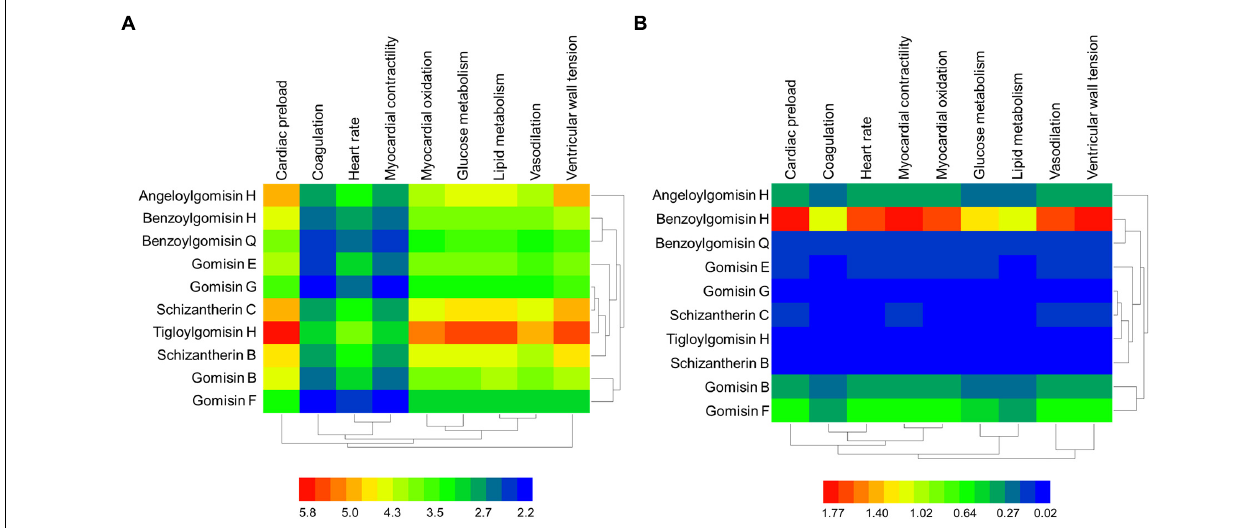
FIGURE 6 | The predicted score heatmap of the Schisandra components related to the effects based on three-mode network. (A) The score matrix calculated from the three-mode network; (B) The score matrix adjusted with the content ratio of Schisandra components.